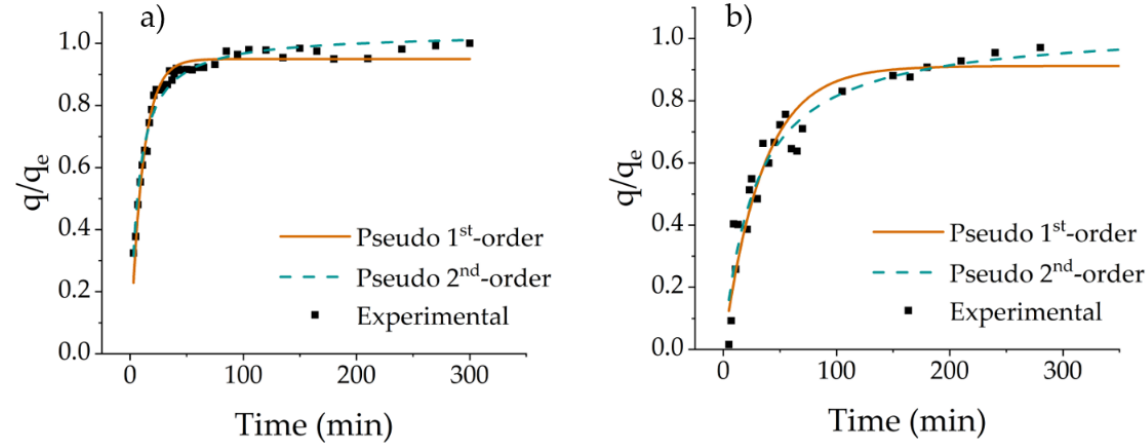
Figure 7. Adsorption kinetics modeling of the adsorption of ( a ) Cyt C and ( b ) Lys onto DCMC.